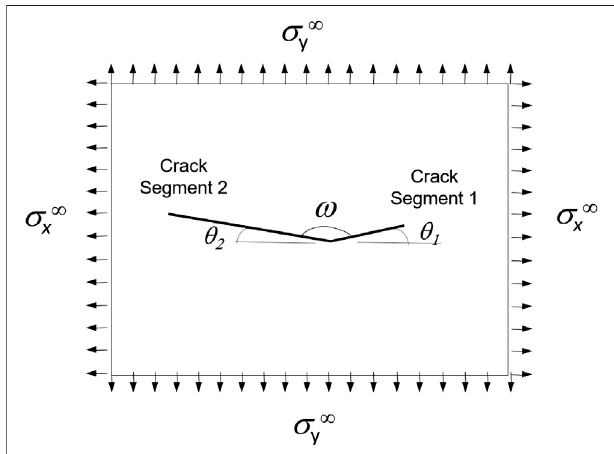
FIGURE 3 | Crack con fi guration for two crack segments and a single